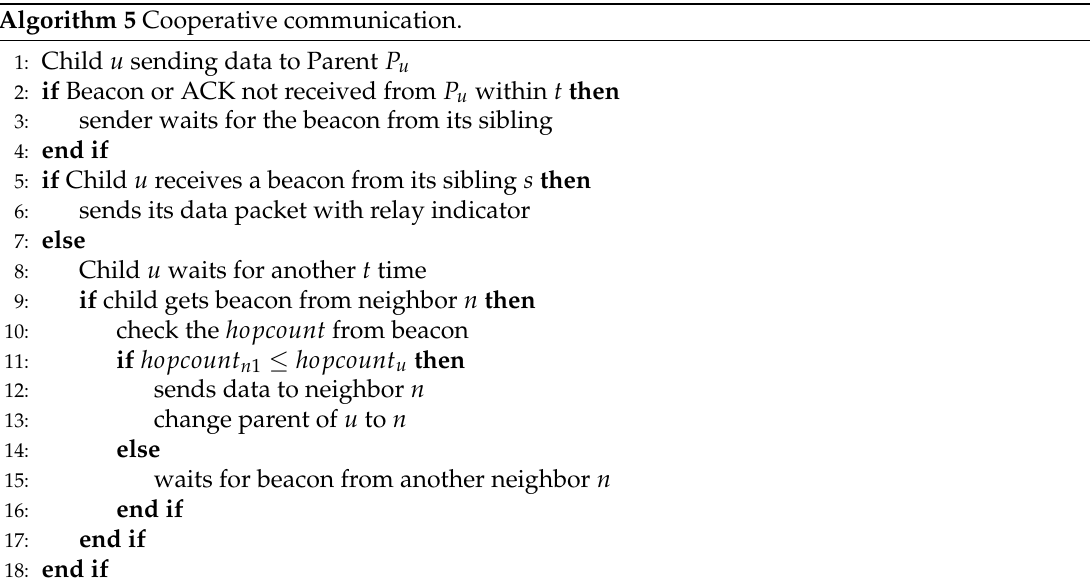
Figure 8. Data loss